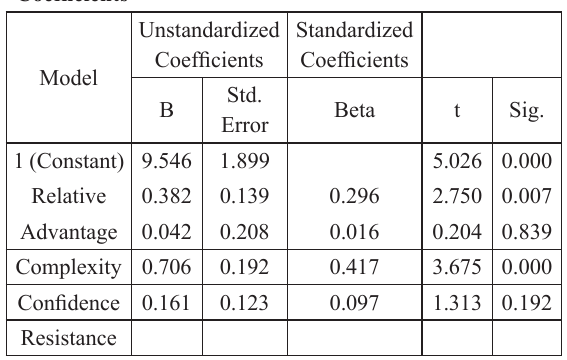
Coefficiency between Confident, Complexity, Relative Advantage, Resistance and E-commerce